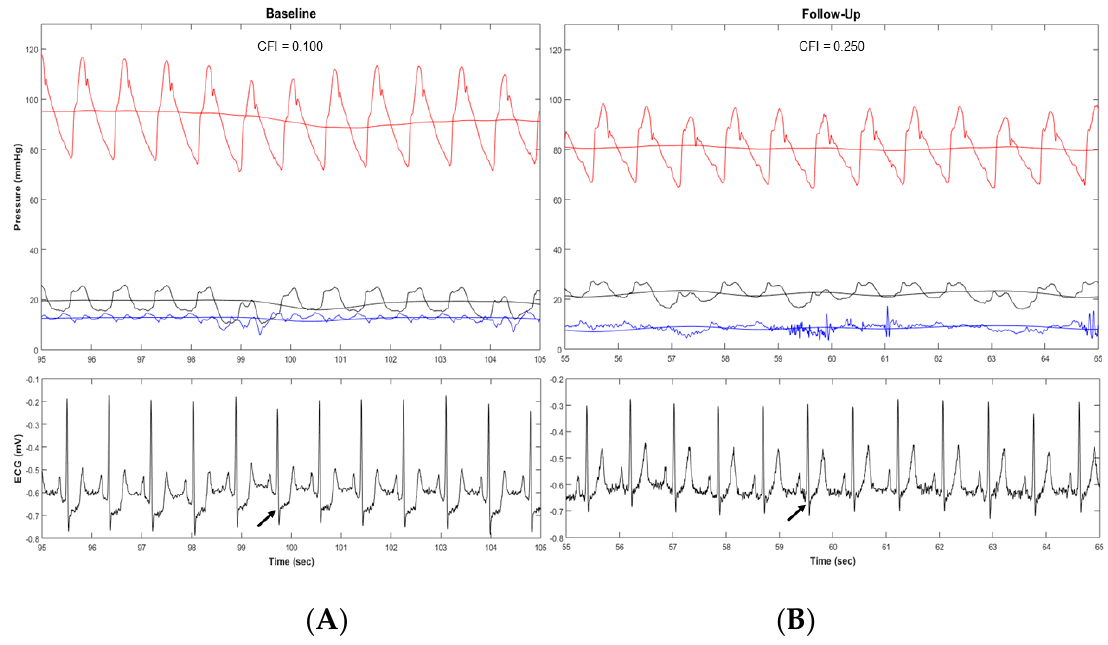
Figure 5. Collateral flow index (CFI) measurements of the right coronary artery (RCA) with corresponding electrocardiograms (ECG) after a one-minute proximal coronary balloon occlusion. ( A ) CFI measured immediately before permanent right internal mammary artery occlusion showing a collateral blood supply of 0.100 and marked ST-deprivations in the ECG as a sign of ischemia (marked with an arrow). ( B ) Six weeks after the permanent occlusion, CFI increased to 0.250 ( + 0.150). This augmented coronary blood supply is reflected by the ECG revealing a decreased ischemia without ST-deprivations (marked with an arrow).